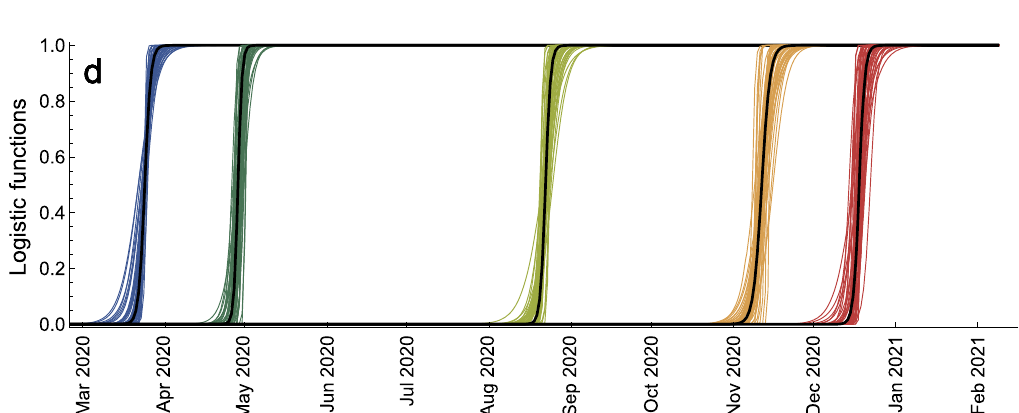
Fig. 9 Contact matrices. a Baseline (pre-pandemic) contact matrix. b Contact matrix after the introduction of measures in April 2020. c Average number of contacts for a person in a given age group. d Logistic functions describing transitions between contact matrices. Shown are f 0 (blue), f 1 (dark green), f 2 (light green), f 3 (orange), and f 4 (red) based on 50 samples from the posterior